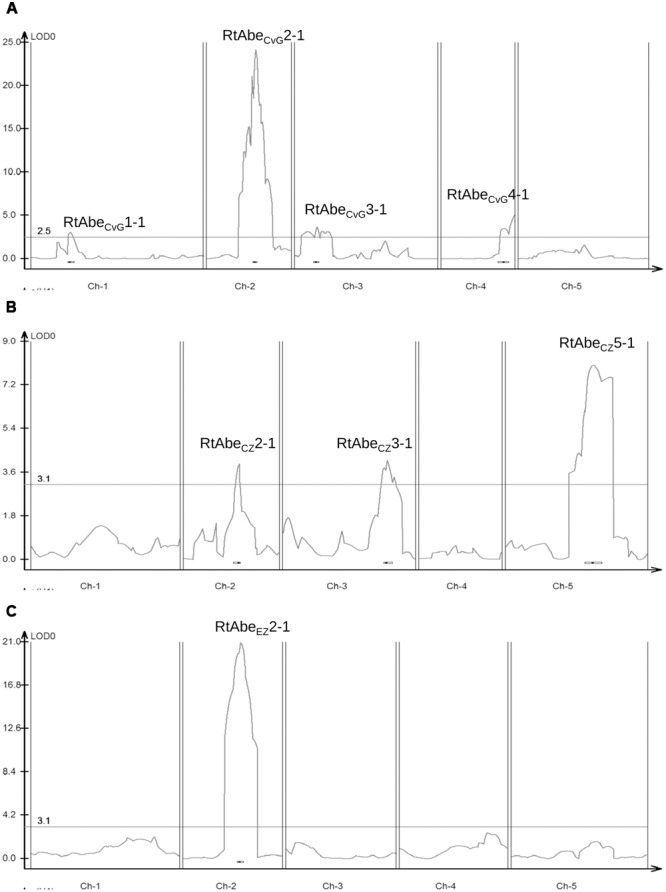
Quantitative trait locus (QTL) likelihood map of the three mapping populations – (A) CvG RIL population; (B) CZ F2 population; (C) EZ F2 population. Horizontal line denotes the threshold LOD value for the respective populations. The QTLs on chromosome 2 viz. RtAbeCvG2-1, RtAbeCZ2-1, and RtAbeEZ2-1 can be seen to align approximately in the same physical interval.